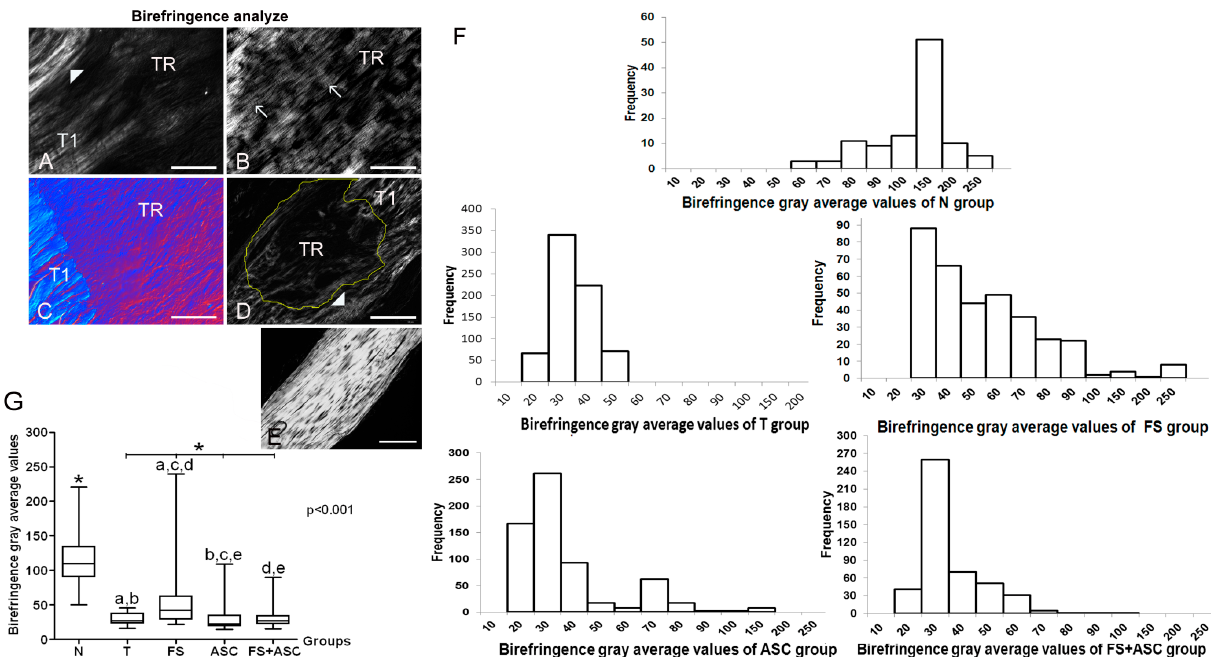
Figure 8. Images of birefringence of tendon longitudinal sections on 21st day using polarization microscopy ( n = 5). The larger tendon axis was set 45° from the crossed polarizers. The variation of brightness intensity (gray levels) is due the variation of the collagen bundles organization. ( A ) T group: little birefringence brightness is observed in TR (tendon transected region) because of the disorganization of collagen bundles. T1 is the region which border the TR. ( ) remaining portion of the tendon located below the TR. ( B ) FS group: the increase in birefringence brightness was remarkable and a typical well-developed crimp ( → ) pattern was observed only in this group. ( C ) ASC group: image using DIC (differential interference contrast microscopy), where it is possible to visualize in red a smaller organization of the collagen bundles and in intense blue (according to Michel-Lévy's table) the high degree of compaction of the collagen bundles. ( D ) FS + ASC group: observe a higher birefringence of the collagen fibers compared to the ASC group and observe an imbrication between collagen fibers that were not cut in T1 and fibrils in the TR (delimited by yellow line). ( ) remaining portion of the tendon located below the TR. ( E ) N group: collagen fibers exhibiting strong birefringence. Bar = 100 μ m ( A , C , D , E ) and bar = 200 μ m ( B , F ) Frequency histograms of birefringence gray average (GA) values expressed in pixels in the groups N, T, FS, ASC and FS + ASC, which reflect the variability of the collagen fibers organization on the TR region of the Achilles tendon. ( G ) Birefringence GA (pixels) median between the groups. The measurements data showed in graphics (f and g) were obtained with the larger tendon axis positioned at 45° from the crossed polarizers. (*) Significant differences between the group N and groups with transected tendons. The same letters between the groups correspond to a significant difference between them.